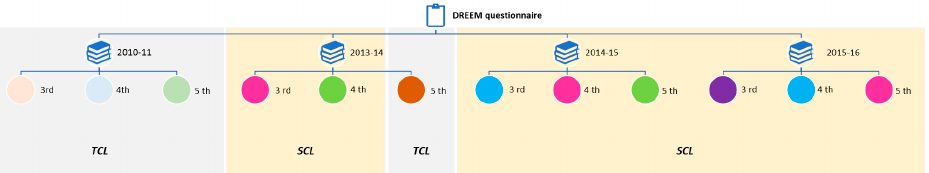
Figure 1. Workflow of study design showing the application of DREEM questionnaire on the different academic years and courses during ‘curricular transition’. Each colour represents a different student’s dental group indicating the same colour the study follow-up. Abbreviations: TCL, teacher-centred learning; SCL, student-centred learning.